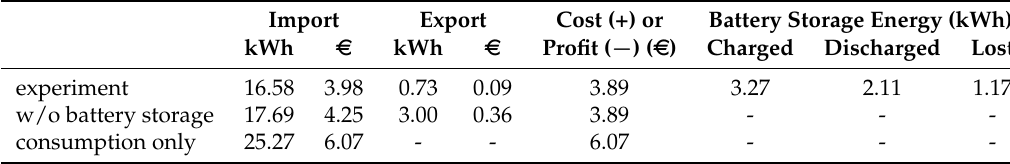
Table 6. Evaluation of first test period (20 March, 00:00 to 21 March, 00:00). All values except for the cost/profit are given as absolute values. The overall energy generated by the photovoltaic plant during the test period is 10.58